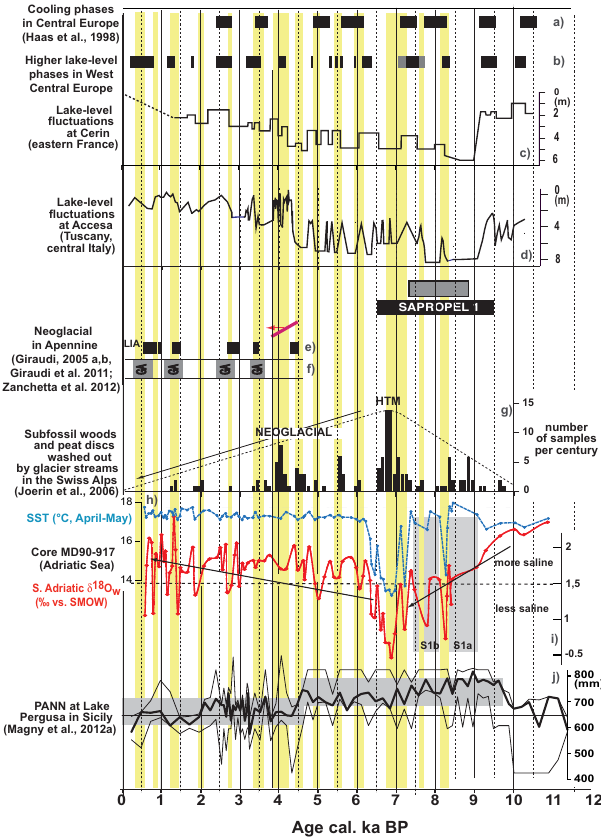
Fig. 6. Comparison between the hydrological record from core MD90-917 (this study) and continental climate proxies: (a) cen- tral Europe cooling events reconstructed from various proxies in the Swiss Plateau and Alps (Haas et al., 1998). (b) Phases of higher lake level in west-central Europe (Magny, 2004, 2006). (c) Lake- level record of Cerin (Magny et al., 2011a); (d) lake-level record of Accesa (Magny et al., 2007). (e) Phases of cooler/wetter climatic conditions reconstructed in southern and central Italy (Giraudi et al., 2011; Zanchetta et al., 2012); LIA = Little Ice Age; red arrow corresponds to the onset of the Neoglacial period. (f) Glacial ad- vances in the Gran Sasso Massif, central Italy (Giraudi 2005a, b); GA = glacier advance. (g) Frequency of subfossil woods and peat discs in proglacial fluvial sediments in the Swiss Alps (Joerin et al., 2006). (h) South Adriatic Sea surface temperature (this study). (i) South Adriatic δ 18 O w record (this study). (j) Pollen-inferred quan- titative estimates of annual precipitation at Pergusa, central Sicily (Magny et al., 2012a). S1a and S1b refer to the two-step sapropel S1 units in the SAS. The yellow lines indicate low δ 18 O w /salinity values in core MD90-917. 2006), (2) cooling events identified from various proxies in the Swiss Plateau and Alps (Haas et al., 1998), and (3) glacier variations reconstructed in the Swiss Alps from radiocarbon- dated subfossil woods and peat discs washed out by glacier streams (Joerin et al.,